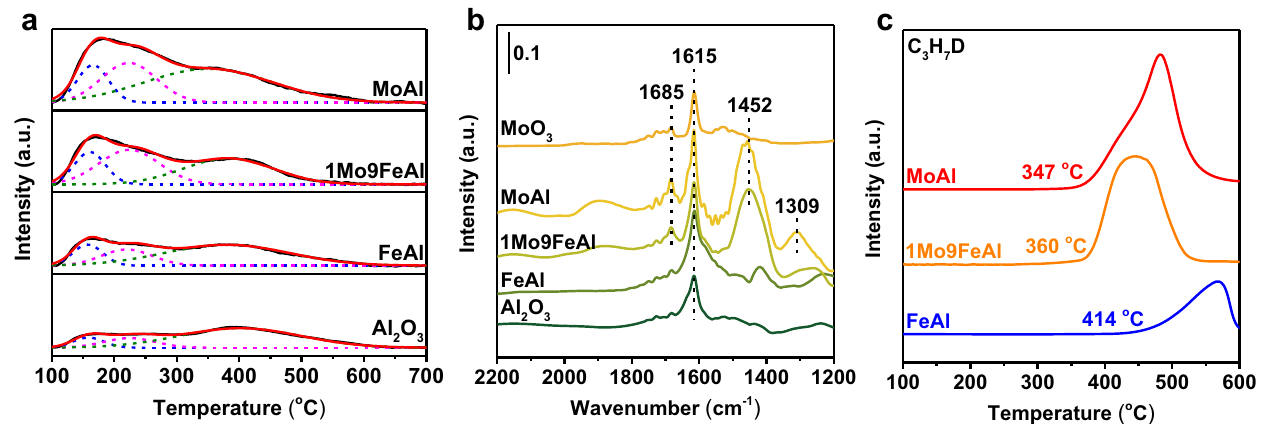
Fig. 4 | Modi fi cation on surface acid properties and its sequent promotion on propaneactivation. ( a )NH 3 -TPDpro fi lesofAl 2 O 3 ,FeAl,1Mo9FeAl,andMoAl.NH 3 - TPD was performed from 100 to 700°C with a rate of 10°C/min after being pre- treated in a fl ow of 5vol% NH 3 in He (20mL/min) for 1h at 100°C. ( b ) NH 3 -DRIFTS